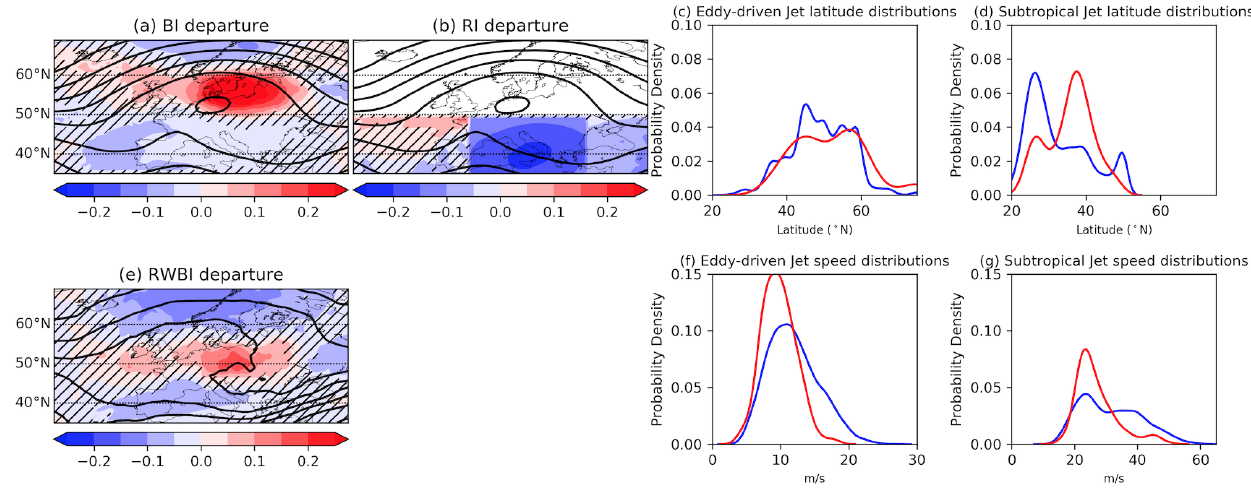
Figure 3. As in Fig. 2 but for stagnation in NEU.